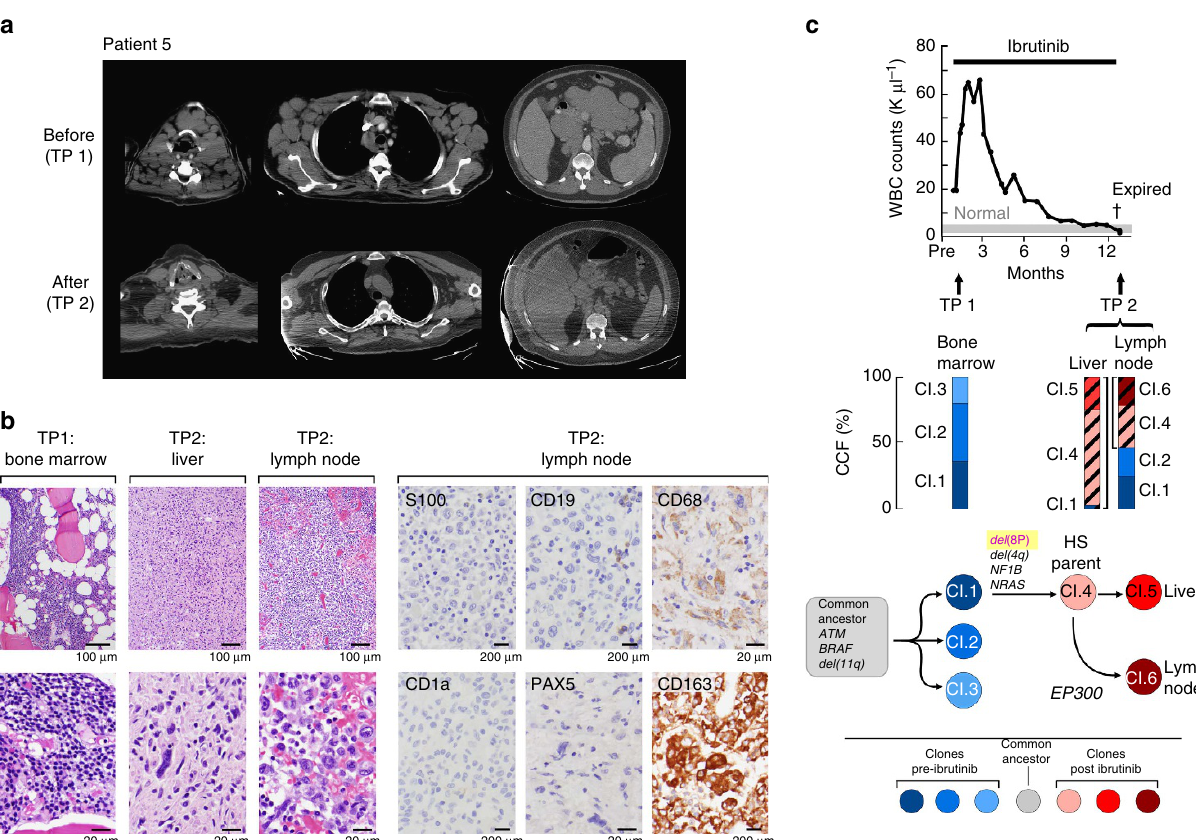
Figure 4 | Histiocytic sarcoma trans -differentiation of CLL during ibrutinib therapy. ( a ) Regression of lymph node (LN) disease, visualized with CTscan, following ibrutinib exposure (at time point (TP) 2), compared with TP1. ( b ) At TP2 (autopsy), histologic sections of liver and LN, stained with haematoxylin and eosin, showed histiocytic sarcoma with sheets of large atypical cells with irregular shaped nuclei, dense nuclear chromatin and abundant cytoplasm (at (cid:3) 100 and (cid:3) 500 inserts). Occasional large neoplastic cells demonstrated one or two prominent eosinophilic nuclei. No lymphoid aggregates were seen. The neoplastic cells within the LN were strongly positive for CD163 and are negative for CD19, CD1a and S100 proteins (all at (cid:3) 500). ( c ) White blood cell counts and clinical course for Patient 5. Whole-exome sequencing and CCF measurements were made before ibrutinib initiation (TP1) and from post-mortem specimens of the liver and LN (TP2). The fraction of cells that shared the mutations that define the histiocytic sarcoma parent clones are represented with black diagonal lines. Phylogenetic analysis was performed based on PHYLOGIC. A complete list of somatic mutations and allelic fractions for each clone is provided in Supplementary Table 2 and Supplementary Figs 1 and